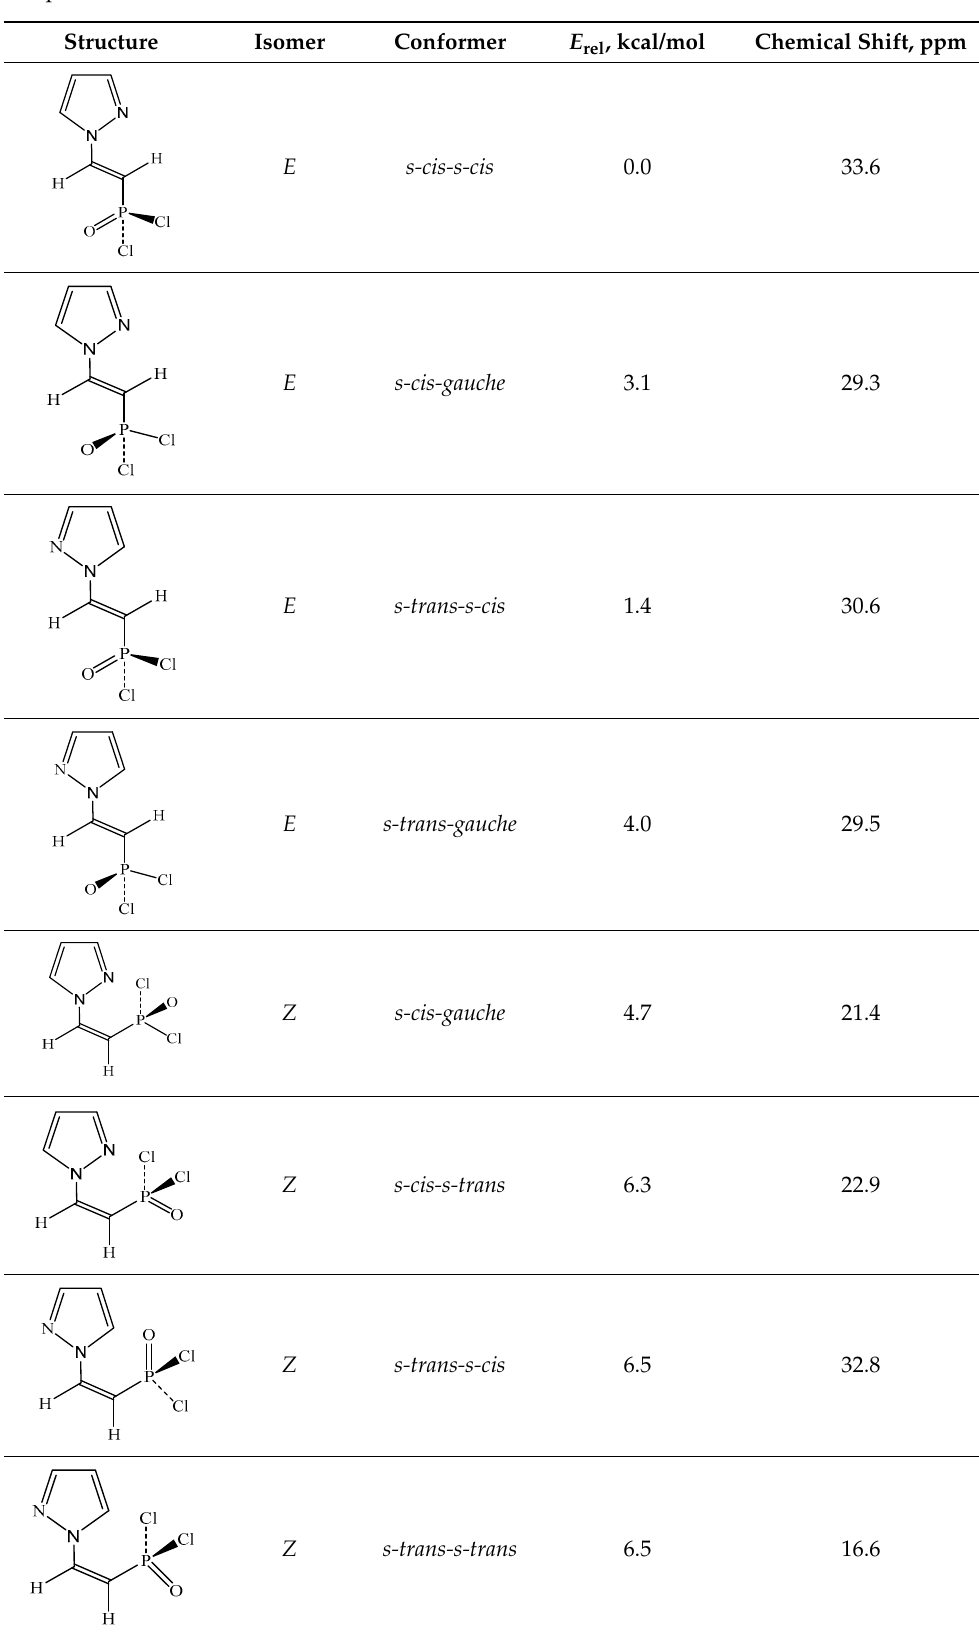
Table 11. Theoretical values of 31 P NMR chemical shifts and relative energies of conformers of the compound 5.